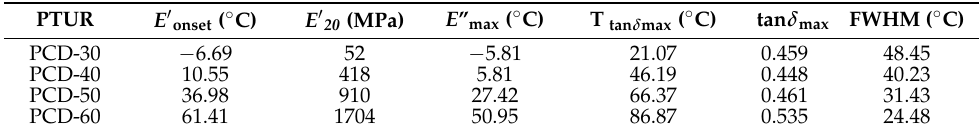
Table 7. Hardness and mechanical properties of PTURs.